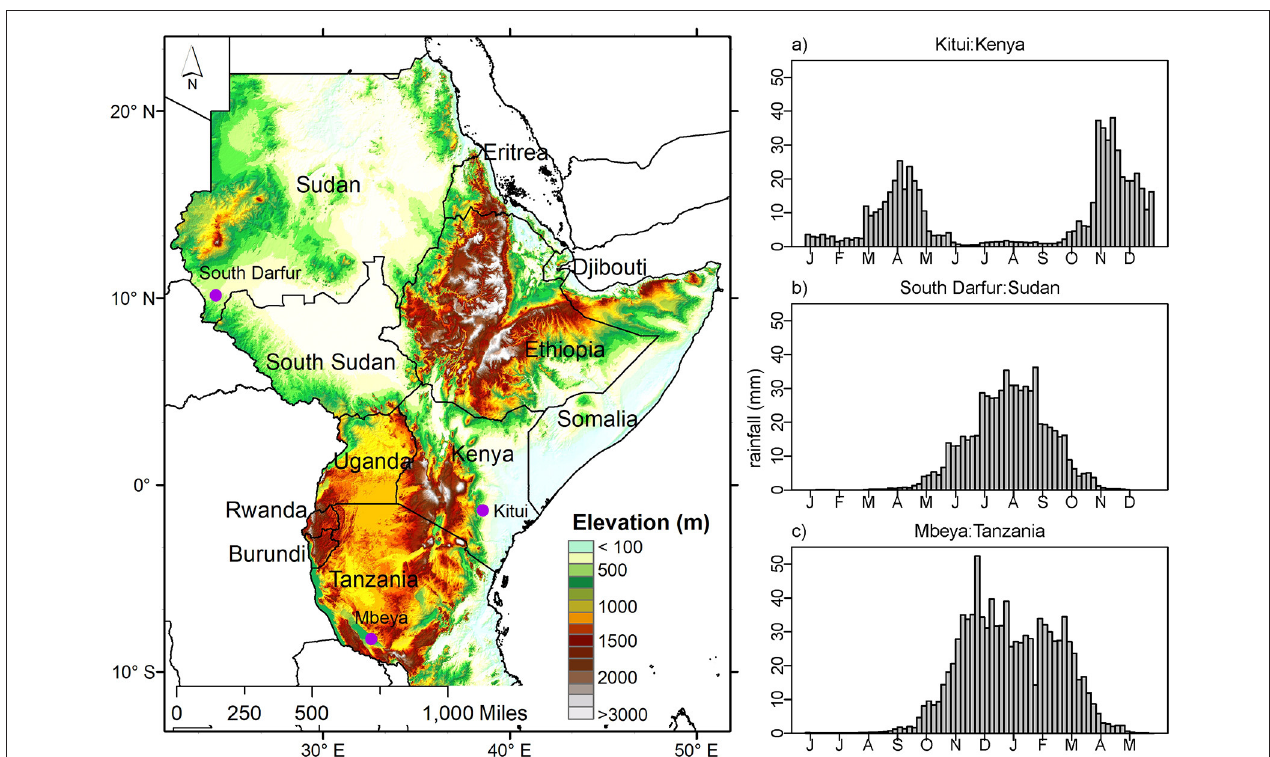
FIGURE 1 | Geographical location of East Africa and average (2000–2018) rainfall over three level 1 administrative districts, (A) Kitui in Kenya, (B) South Darfur in Sudan, and (C) Mbeya in Tanzania. Rainfall source: Climate Hazards Infrared Precipitation with